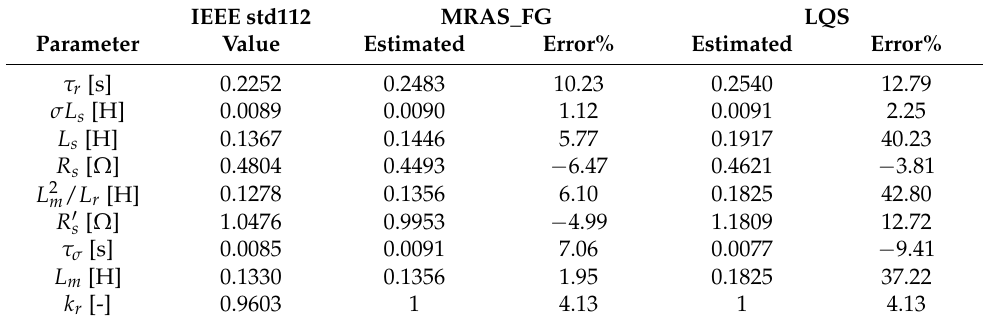
Table 4. Comparative results for the IM electrical parameters estimate